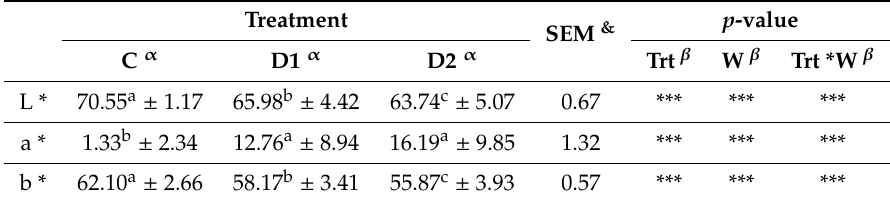
Table 5. E ff ect of spirulina on egg yolk color. Treatment